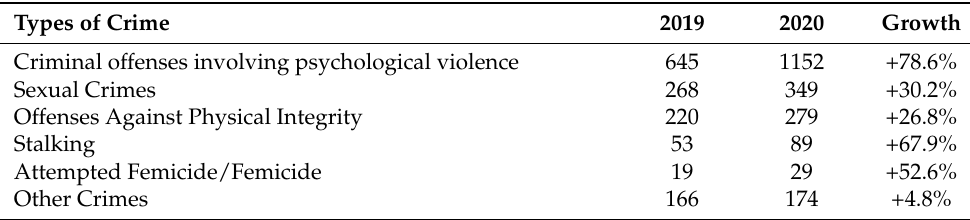
Table 3. Non-IPV crimes reported in requests for help during 2019 and